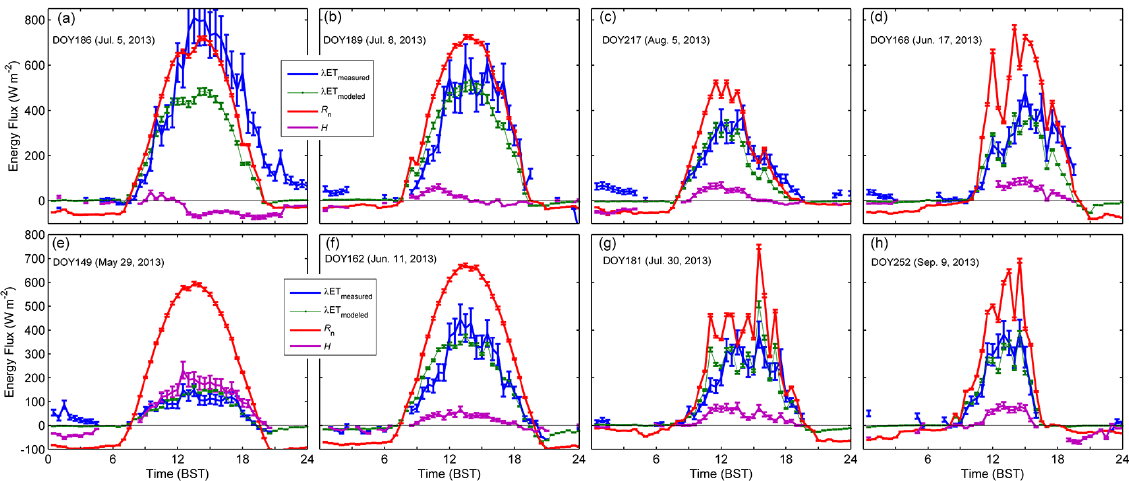
Figure 9. Diurnal variations in R n (Wm − 2 ) , H (Wm − 2 ) , and modeled and measured evapotranspiration flux ( λ ET;Wm − 2 ) . (a – c) represent conditions at which microscale advection occurred at 12:00, 15:00 and 17:00BST, respectively, (d) represents a rainy day, and (e – h) represent clear and advection-absent days during the study period. A gap is caused either by the absence of flux measurements or missing ancillary data. Modeled λ ET was presented as median ± 95% posterior predication